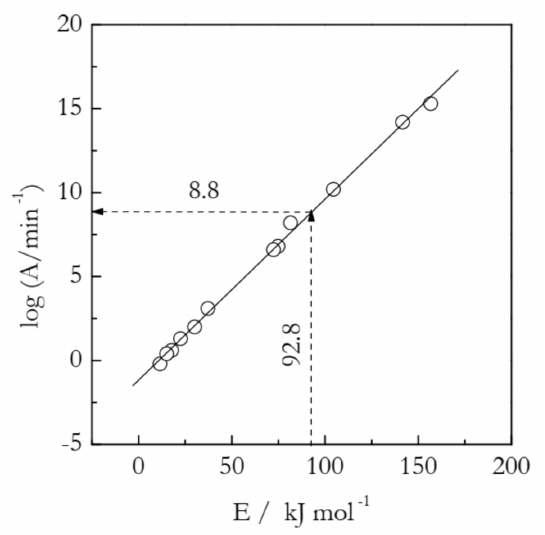
Figure 1. Compensation effect (solid line) for thermal decomposition of ammonium nitrate. Circles are individual ln A i and E i values calculated for 12 models from Table 1. A model-free estimate of ln A (8.8) is determined by substituting a model-free value of E (92.8 kJ mol − 1 ) into the compensation effect Equation (5). Adapted with permission from Vyazovkin et al. [13]. Copyright 2001